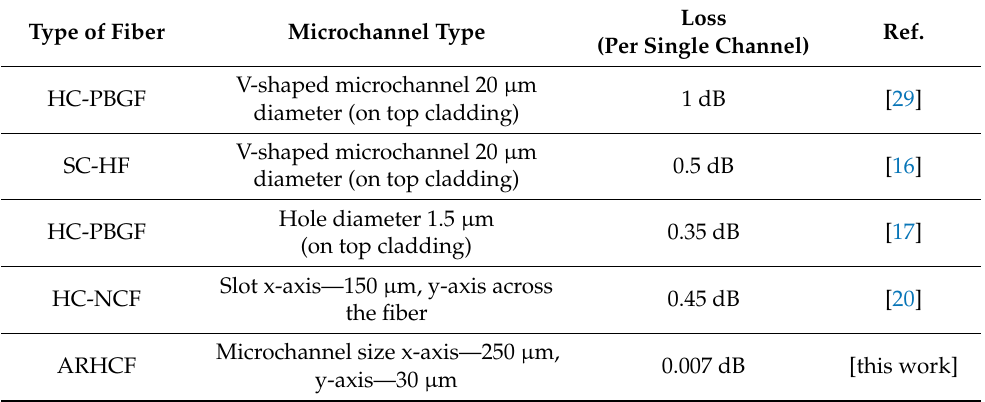
Table 2. Comparison of the losses induced by microchannels in